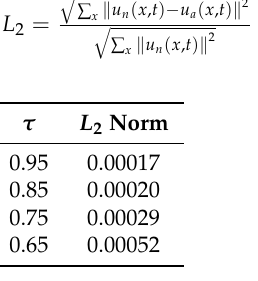
Table 1. L 2 norm for different viscosities. L 2